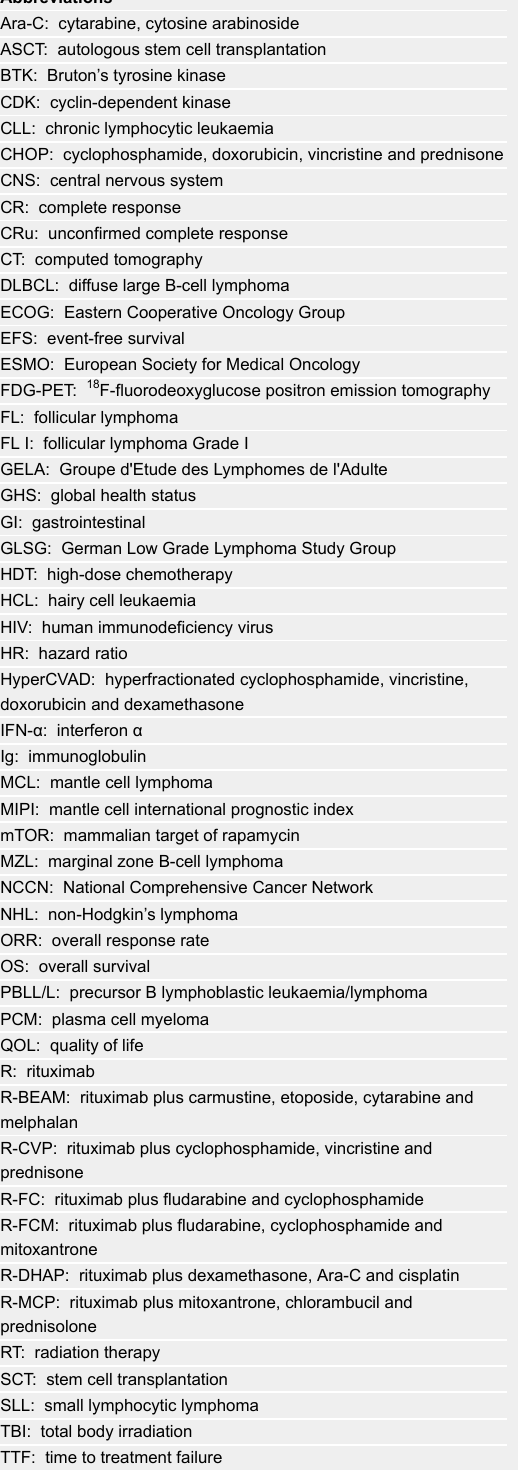
Cytomorphologic subtypes of mantle cell lymphoma: (A) classical, (B) small cell variant, (C) blastoid variant, (D) pleomorphic